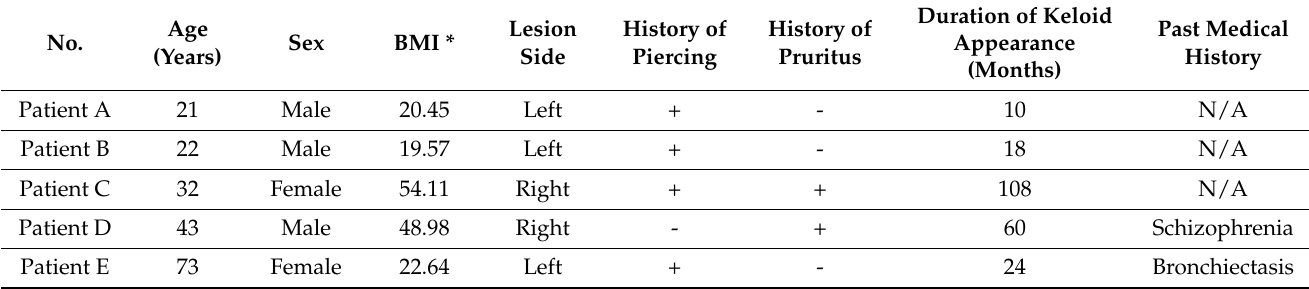
Table 3. Demographic and risk factor data of the study participants.